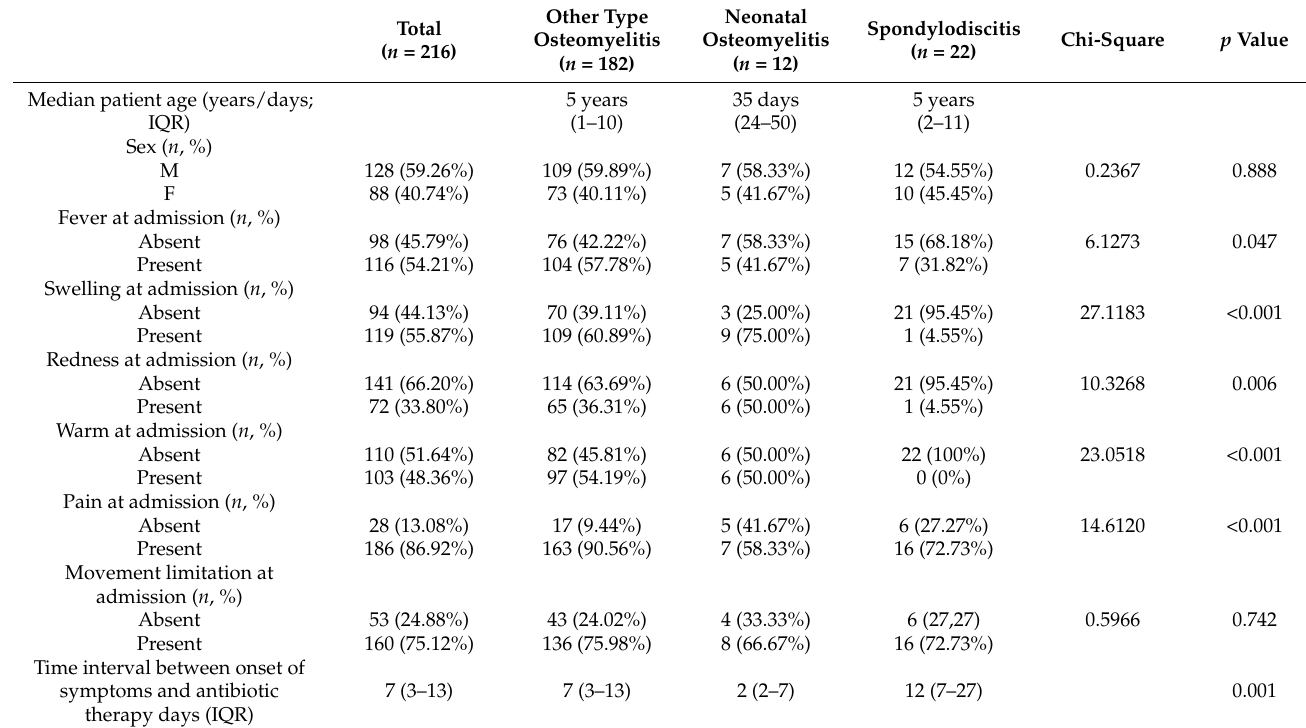
Table 1. Characteristics of included